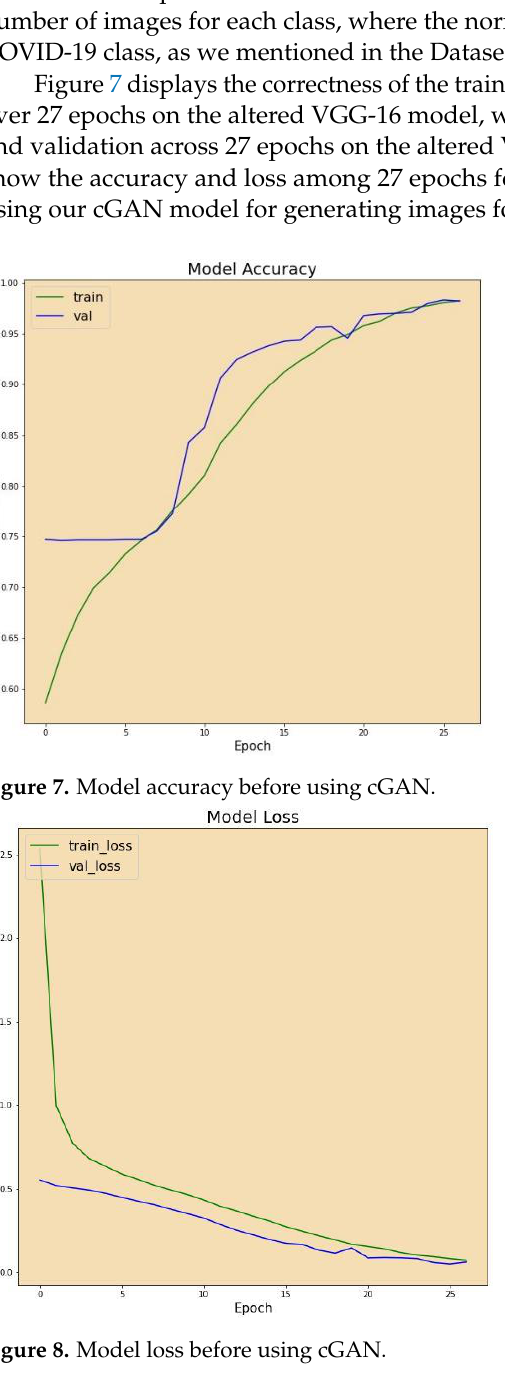
Figure 9. Model accuracy after using cGAN. Figure 10. Model Loss after using cGAN.